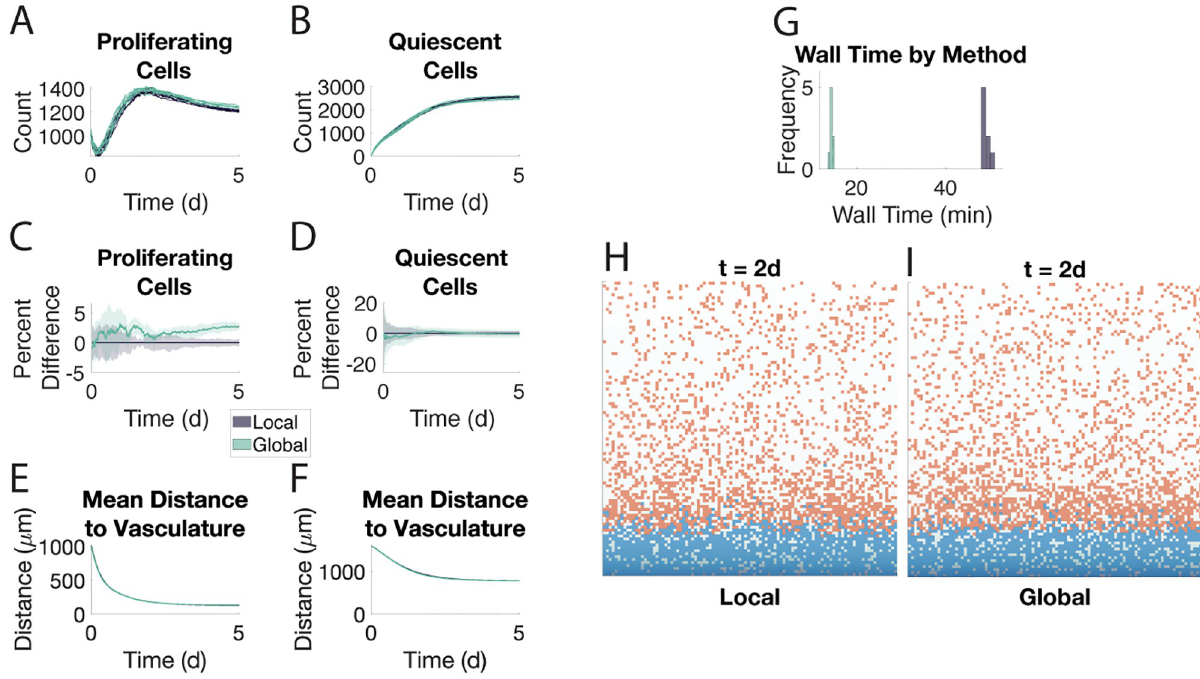
Fig 3. The global method agrees with the local method when quiescence is modeled as an event. Eight samples of each method are shown. Direct Euler was used to solve the intracellular signaling ODE. See caption for Fig 2.